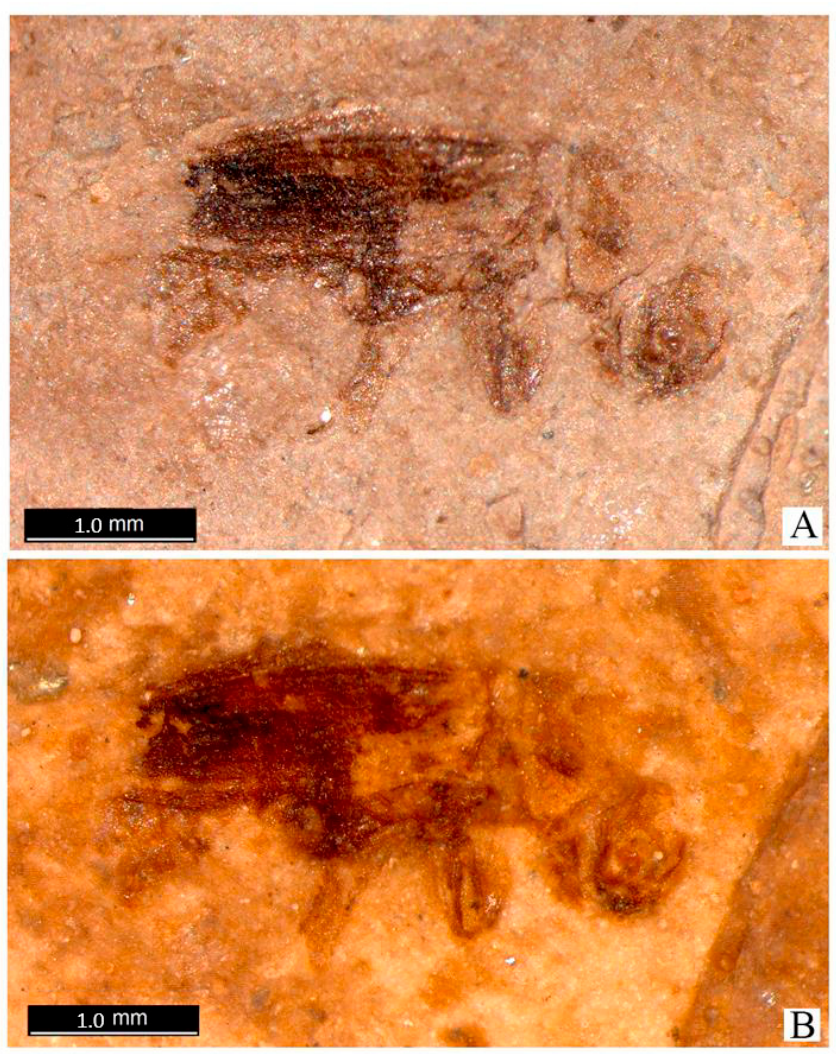
1. Posterior margin of prosternum laterally straight (Figure 1C) or weakly curved in —Posterior margin of prosternum laterally strongly curved in pleural area (Figure 2. Posterior margin of prosternum laterally straight (Figure 1C). Metacoxal cavities not strongly encroaching on first ventrite. Second ventrite longer or subequal to third ventrite. Protibia without costate rugas. Third tarsomere narrow and conical. Three-segmented antennal funicle. Elytra simple, with convex unarmed declivi- —Posterior margin of prosternum laterally weakly curved (Figure 4H). Metacoxal cavities strongly encroaching on first ventrite. Second ventrite shorter than third ventrite.